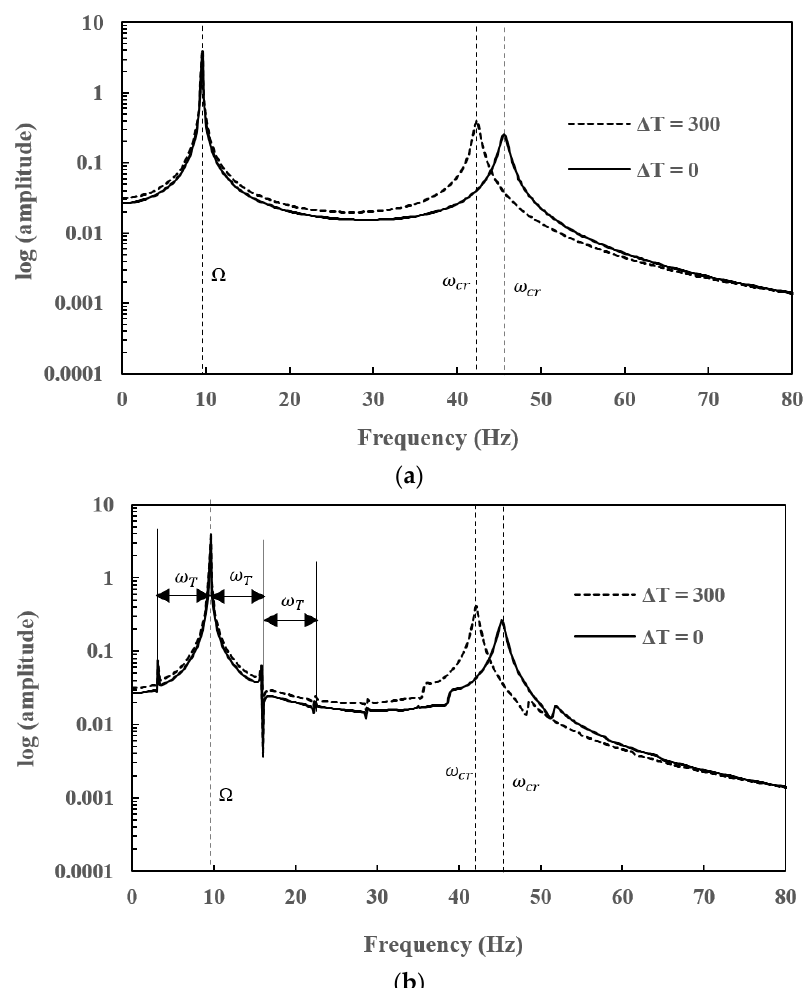
Figure 12. Steady − state FFT of ( a ) uncracked ( b ) slant − cracked EG rotor − bearing system with a rotor speed ( Ω ) of 60 rad/s, torsional frequency ( ω T ) = 40 rad/s and, α = 0.3 at ∆ T = 0 and ∆ T = 300